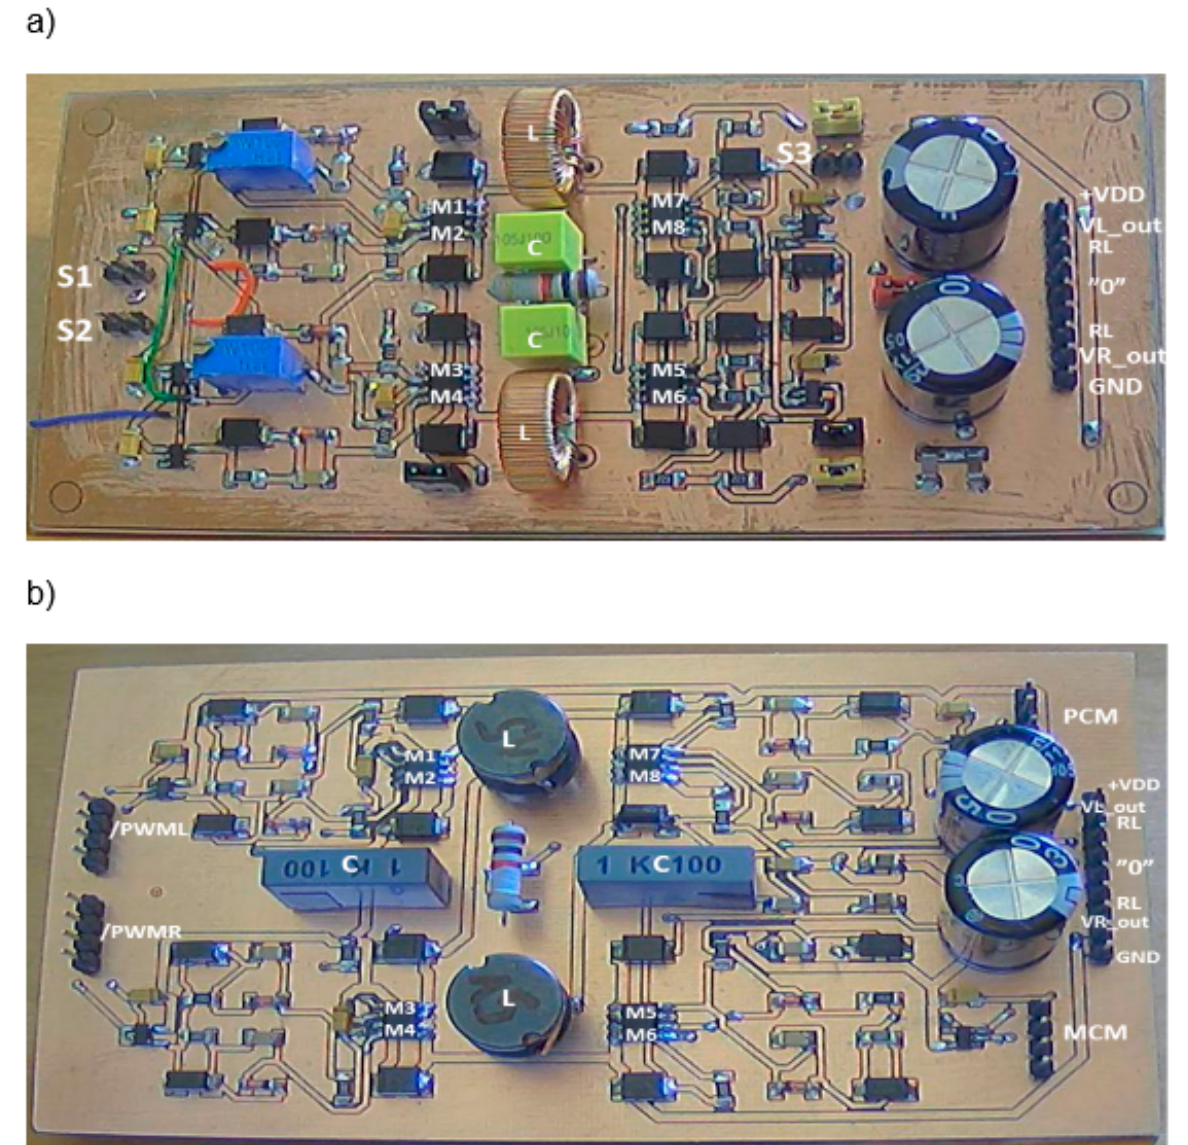
Figure 10. The PCBs of the tested Class-BD audio amplifiers with balanced CM output, implemented on complementary pairs HEXFET ® Power MOSFET IRF9389PbF: ( a ) shown in Figure 4, using the extended NBDD PWM modulator; ( b ) shown in Figure 5, using the extended PSC PWM